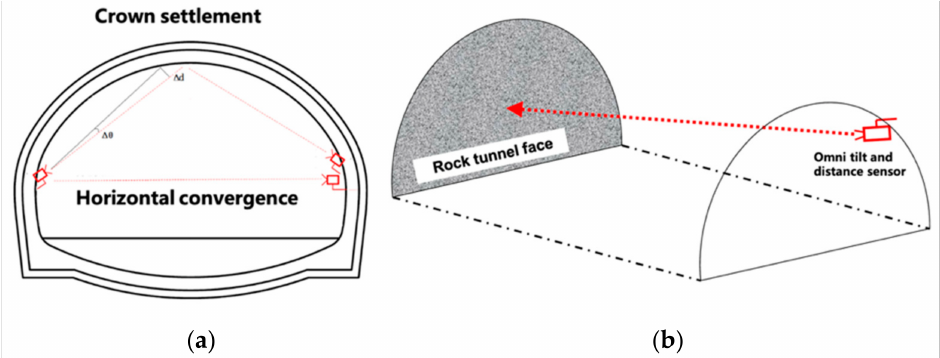
Figure 1. Sensor locations for monitoring deformations in: ( a ) typical tunnel transverse section; ( b ) tunnel